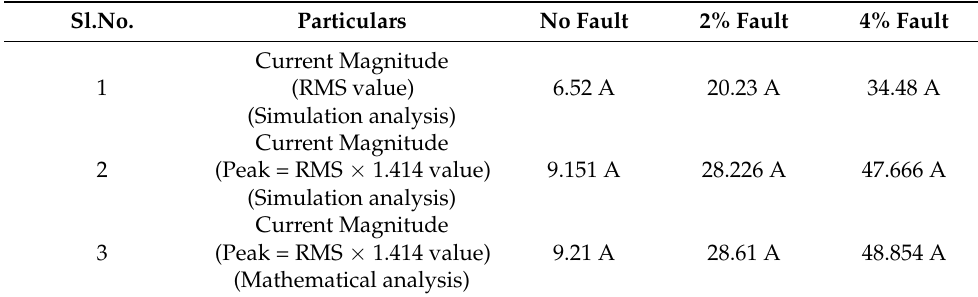
Table 5. Magnitudes of internal fault currents for different cases.